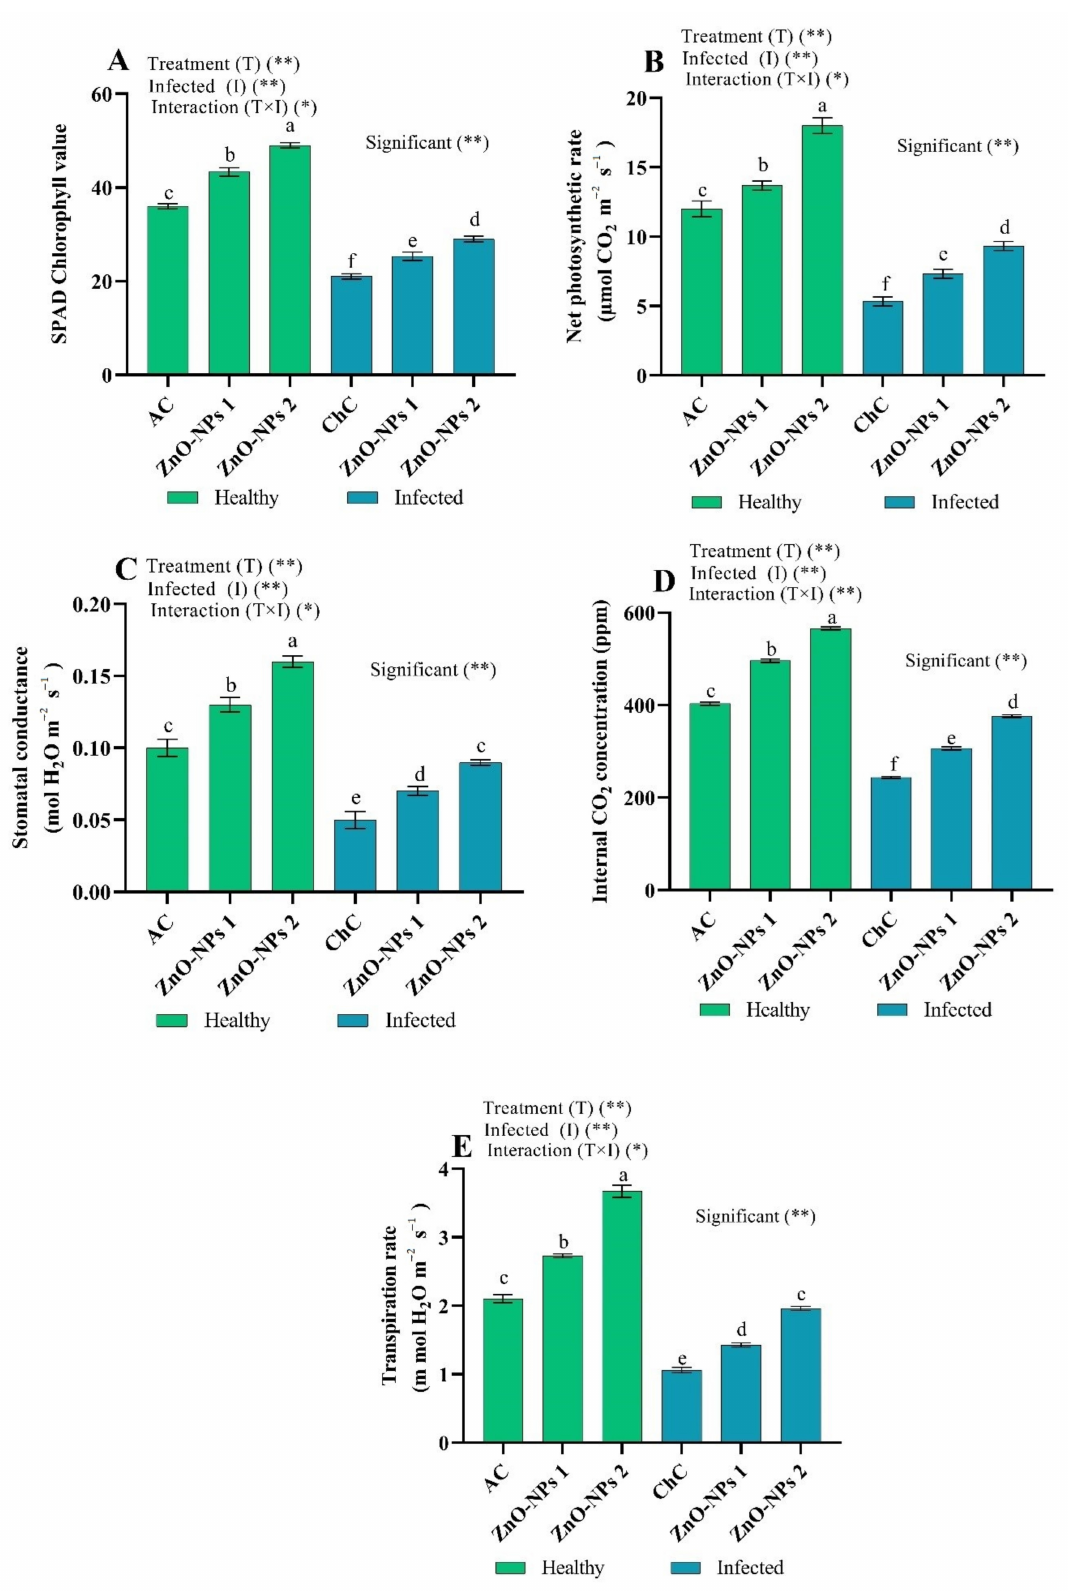
Figure 5. ( A – E ) Effect of foliar spray by ZnO-NPs1 (50 mg/L) and ZnO-NPs2 (100 mg/L) on tomato chlorophyll content and photosynthetic characteristics under absolute control (AC) and Tomato mosaic virus (ToMV) infection (ChC). According to the Fisher test, the different letters (a, b, c, d, e, f) are significantly different at 0.05%. Vertical bars represent the means of three independent determinations ± standard error (SE). * and ** suggest significant and highly significant